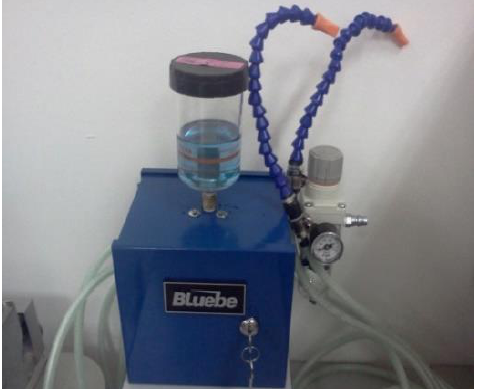
Figure 1: The BLUBE MQL system